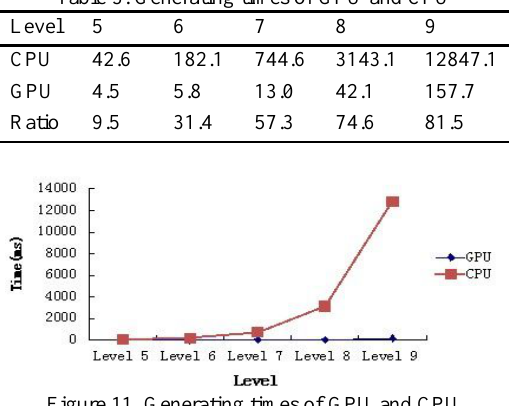
Figure 11. Generating times of GPU and